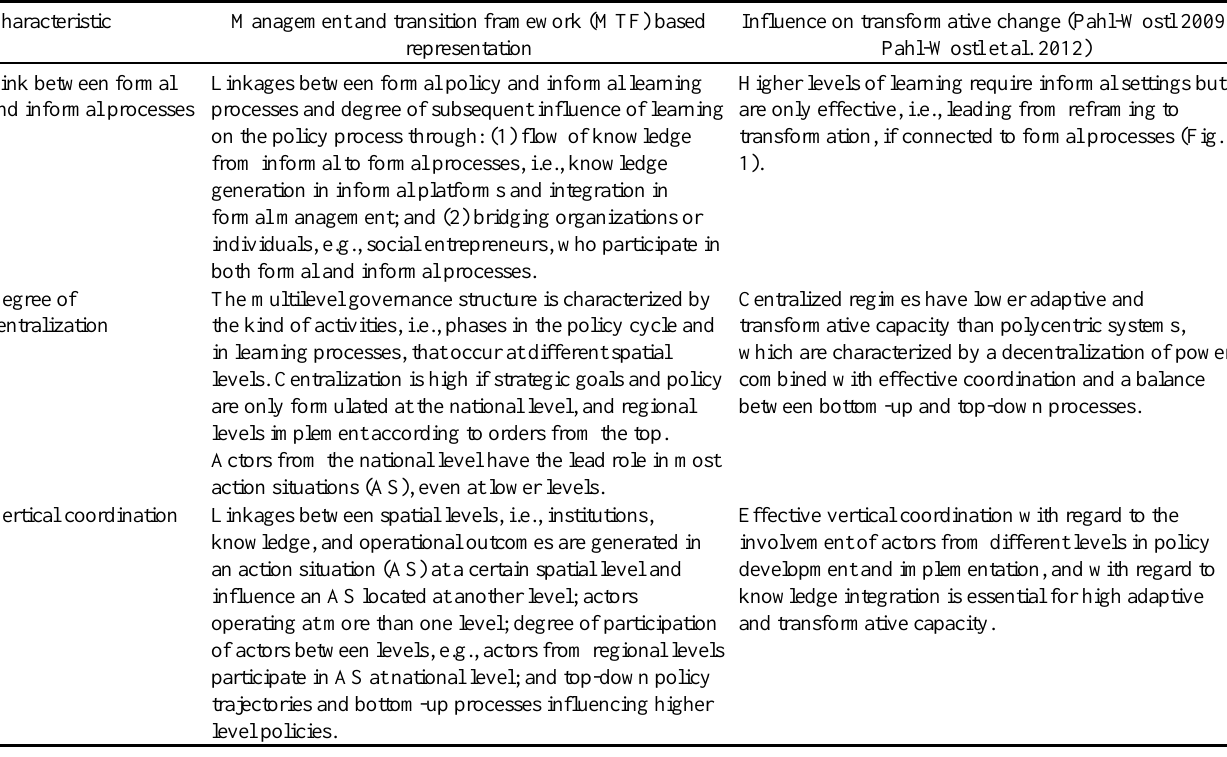
Table 1 . Characteristics of governance systems and expected influence on transformative change. Characteristic Management and transition framework (MTF) based Influence on transformative change (Pahl-Wostl 2009, representation Pahl-Wostl et al.